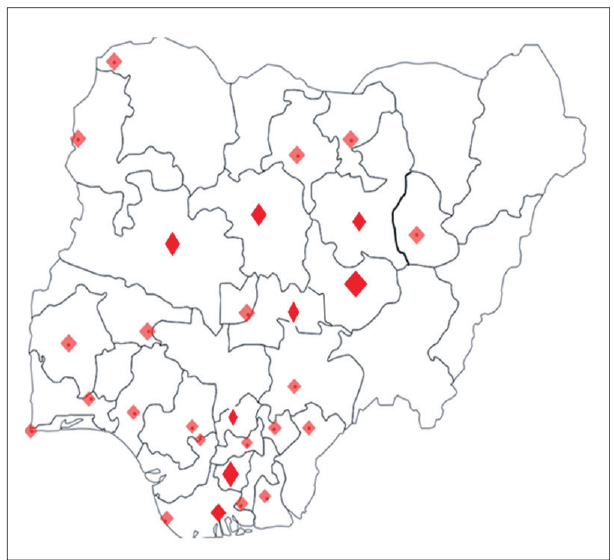
FIG URE 1: States that participated in the (FCT) Abuja (Figure 1). A cross-sectional study design was